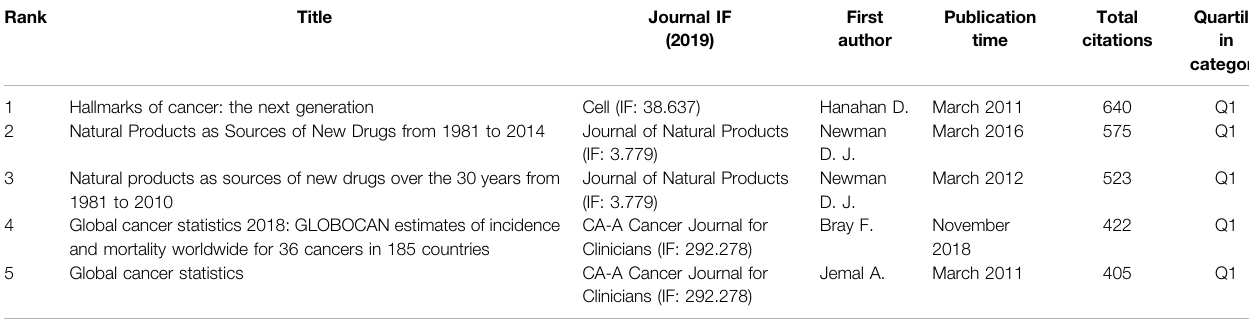
TABLE 6 | The top fi ve high-cited references related to natural products in cancer research.